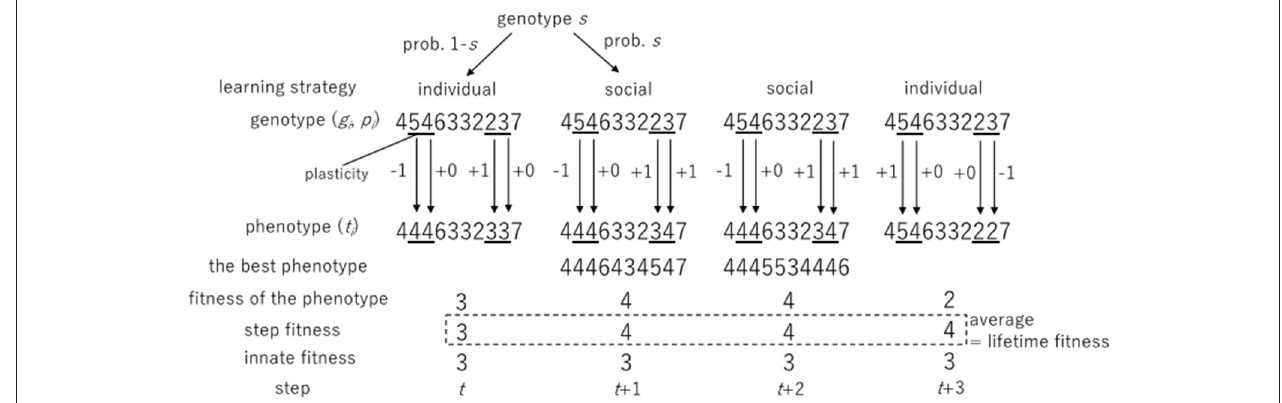
FIGURE 3 | An example of learning process.